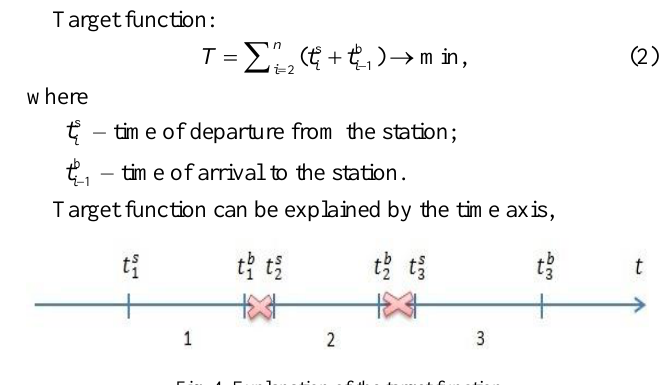
Fig. 4. Explanation of the target